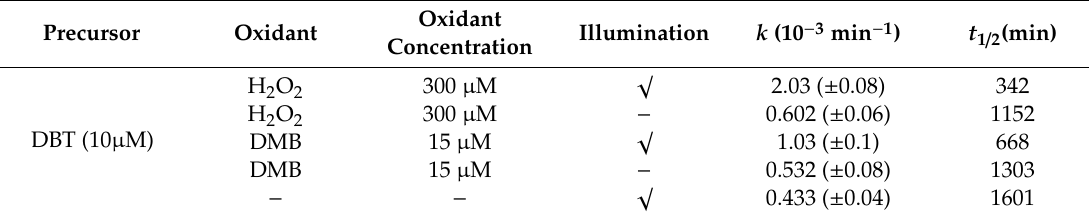
Table 1. Experimental conditions and the decay parameters of DBT.